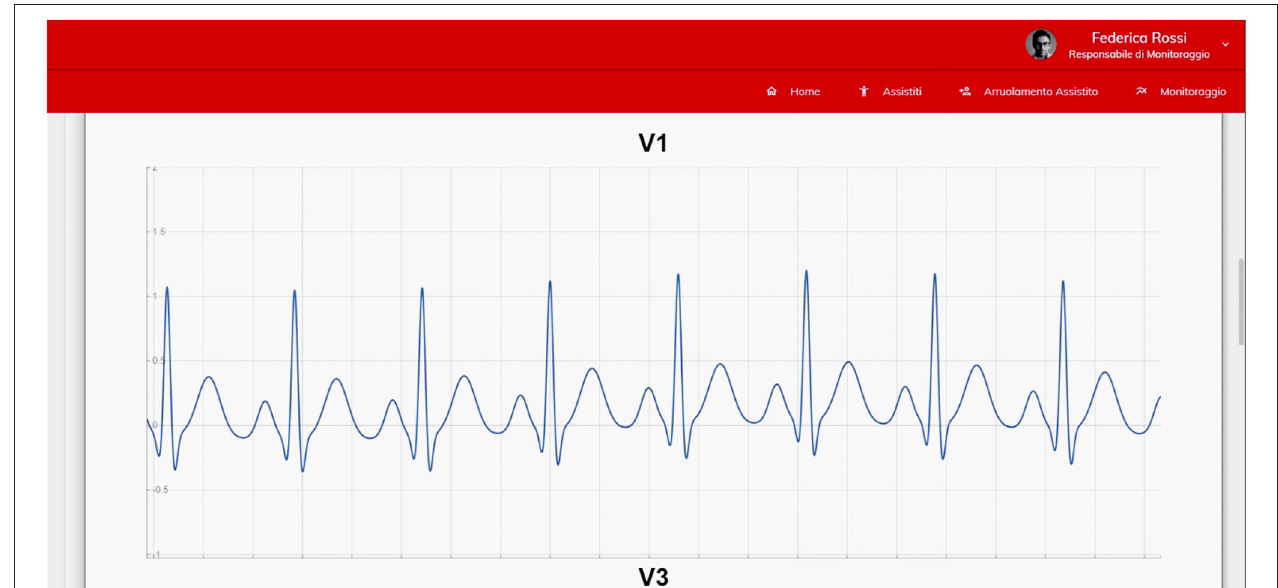
FIGURE 6 | The real-time monitoring feature of the monitoring